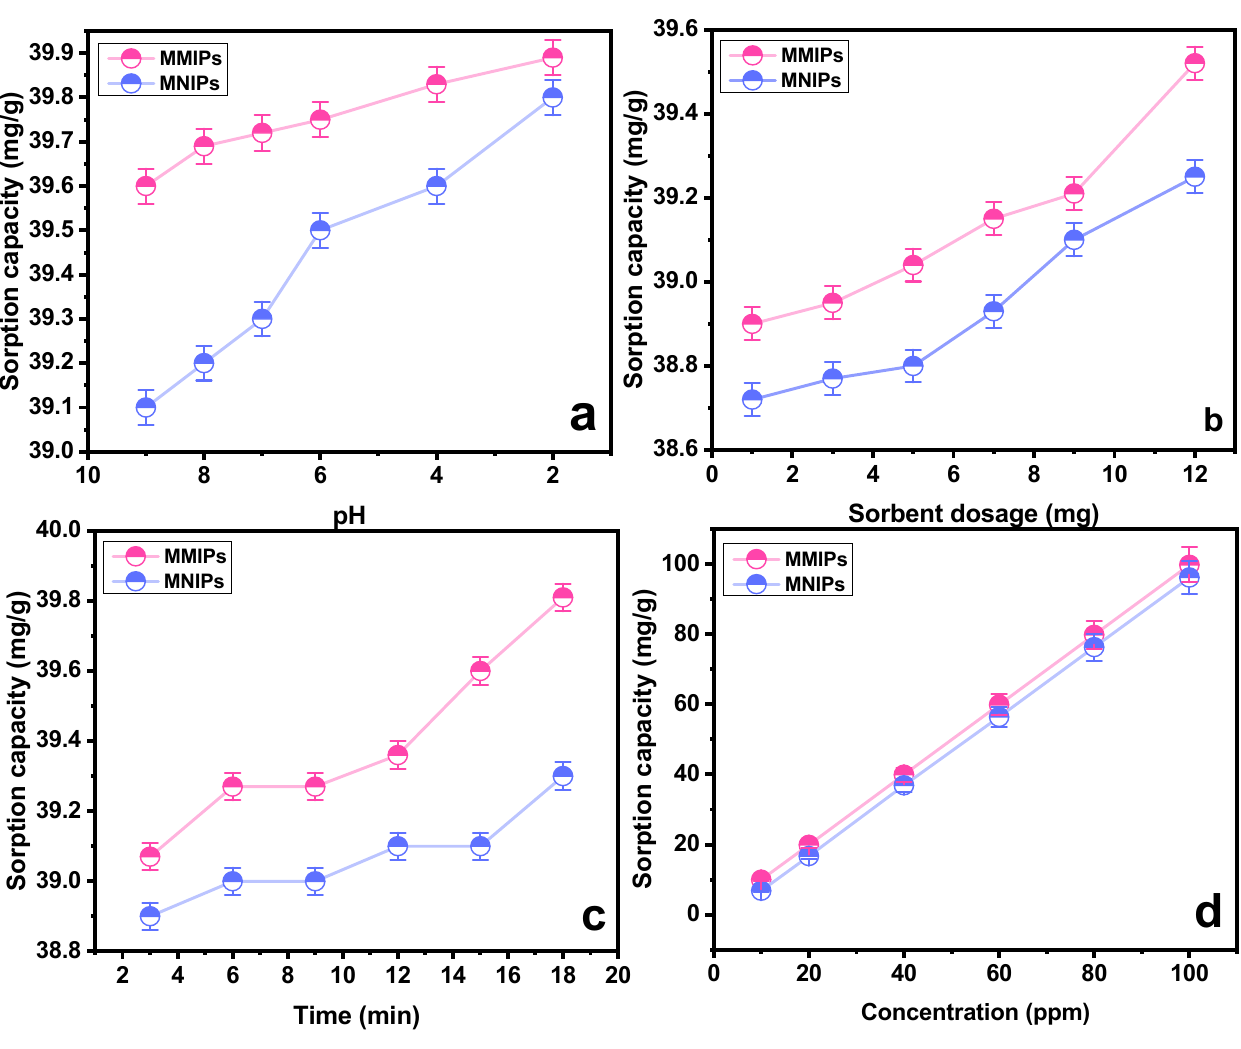
Figure 5. Effect of ( a ) pH on sorption of SY dye onto MMIPs and MNIPs ( b ) sorbent dosage on sorption of SY dye onto MMIPs and MNIPs ( c ) time on sorption of SY dye onto MMIPs and MNIPs ( d ) concentration on sorption of SY dye onto MMIPs and MNIPs.